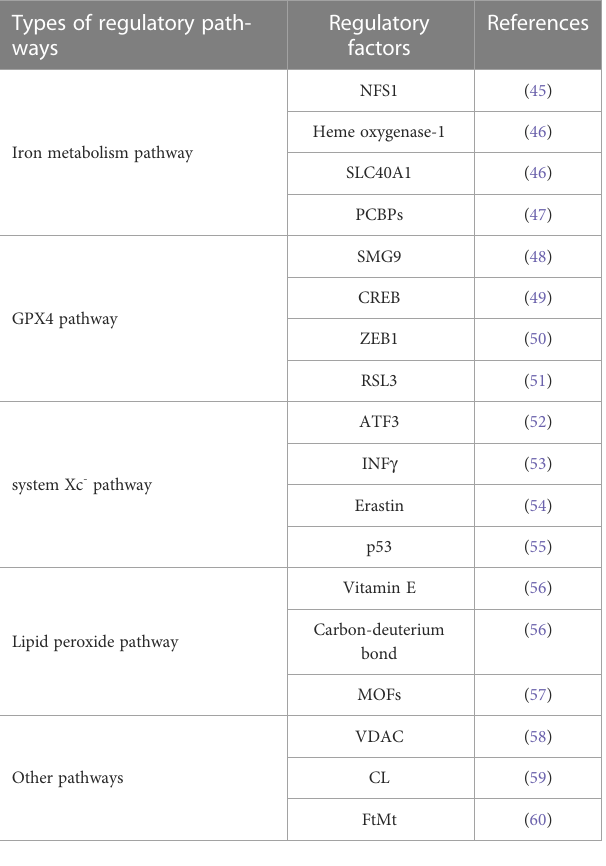
TABLE 1 Major regulatory mechanisms of